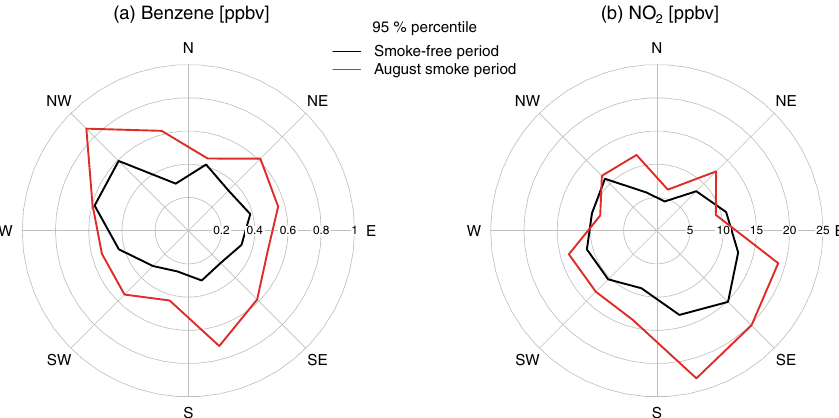
Figure 4. 95th percentiles of all hourly average measurements of (a) benzene and (b) NO 2 during the smoke-free period (in black) and the August smoke-impacted period (in red), as a function of wind direction.